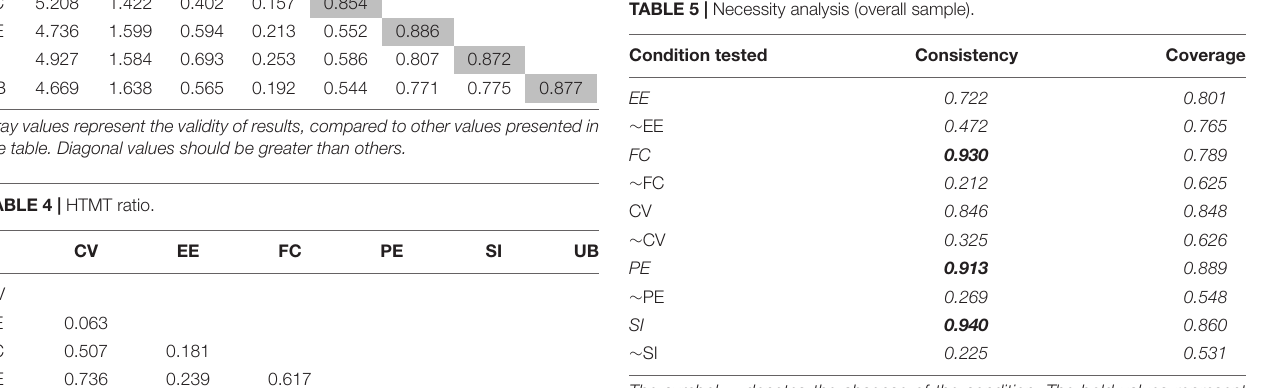
TABLE 5 | Necessity analysis (overall